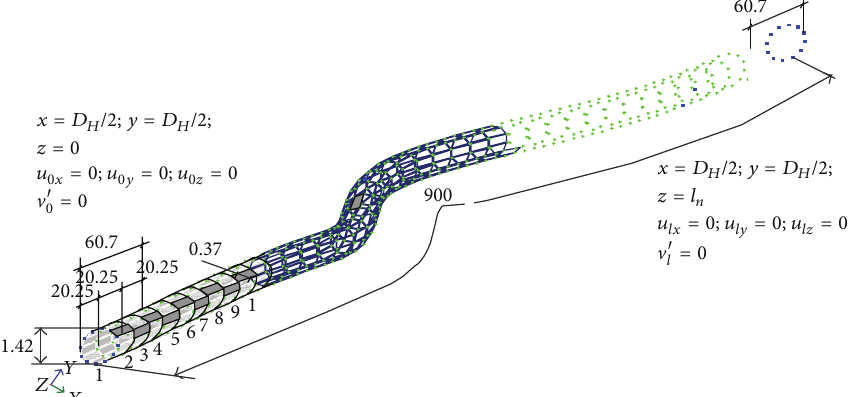
Figure 4: Basic arrangement of the pipeline section with rigidly fixed ends.